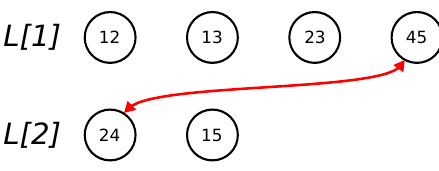
Figure 11: Example: exchange of elements of Ω k in order to lead to a valid vine structure.